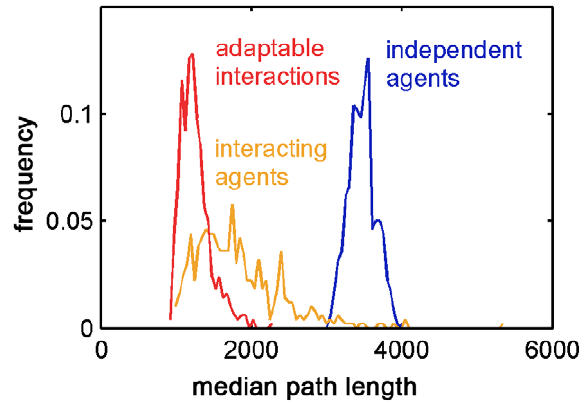
Figure 9. Distribution of navigation path lengths for the different interaction mechanisms. The mean median path length of agents with adaptable interactions is lower than that of both interacting and independent agents. The mean path length of independent agents is significantly larger. The variance of the path lengths of interacting agents is larger than that of the other mechanisms due to positive feedback. Simulation parameters are as in Figure 5, 500